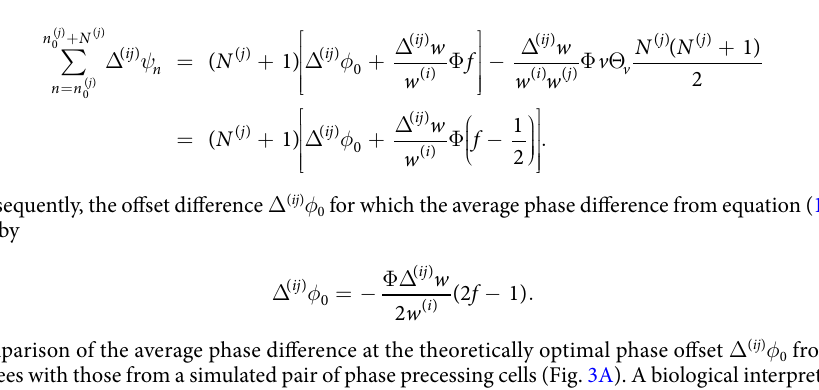
w ( i ) to place cells with width w ( j ) . We therefore computed Δ ( ji ) φ 0 = −Δ ( ij ) φ 0 for a pair of place fields as a function the beginning of the field) the optimal phase offset Δ ( ji ) φ 0 for small fields is positive (delayed) corresponding the center of the field) the optimal phase offset is mostly close to zero (synchronous) corresponding to a global oscillation. Finally, for f = 1 (spike timing encodes the distance to the end of the field) the optimal phase offset for small fields is negative (advanced) corresponding to a wave traveling from small place fields to large place fields as it would be consistent with the observed traveling direction of the theta wave. The maximum phase offset (for the smallest place fields) is the 180° (Fig. 3E) found in experiments 18, 19 .